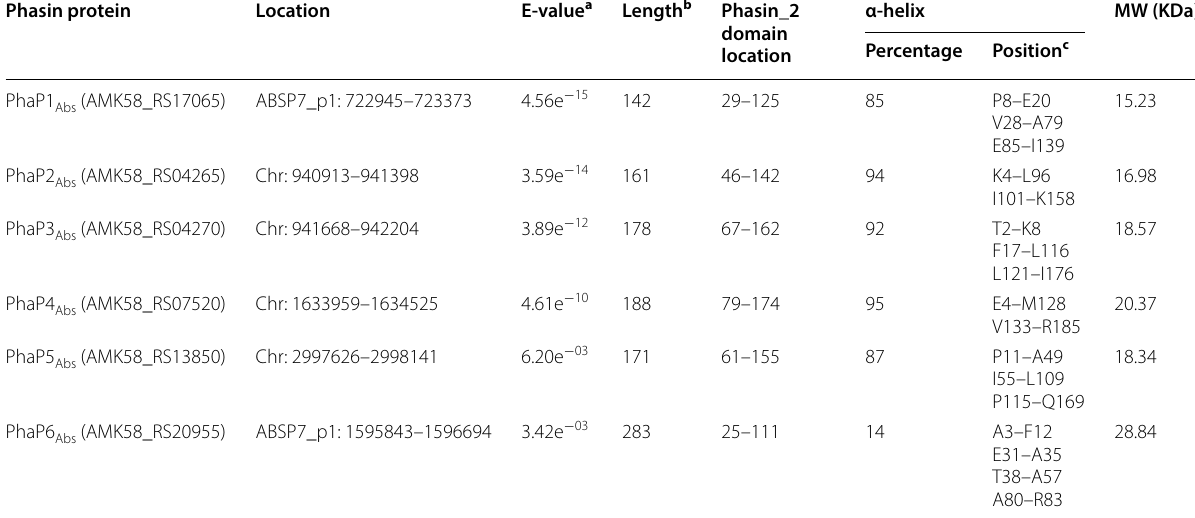
a The E‑value was obtained from the alignment of each phasin protein with the Phasin_2 domain b Amino acids c Amino acids